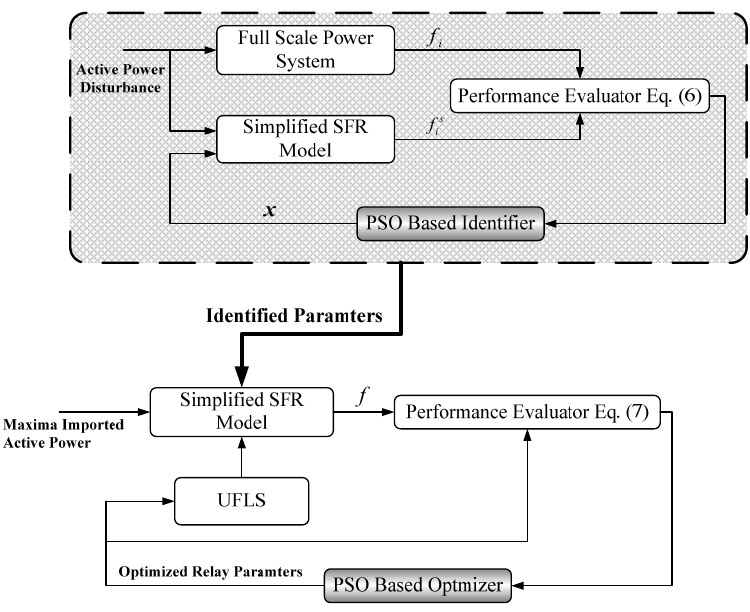
Figure 8. Block diagram of the proposed PSO-based UFLS scheme design.